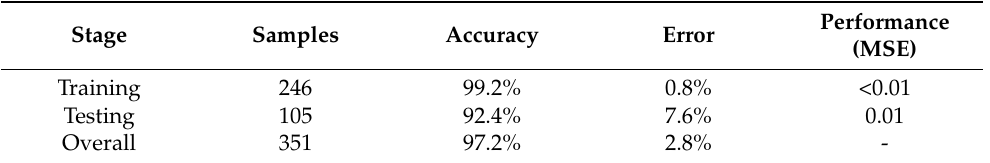
Table 4. Results from the classification machine learning model to predict wine vintages. Abbrevia- tions: MSE—means square error.